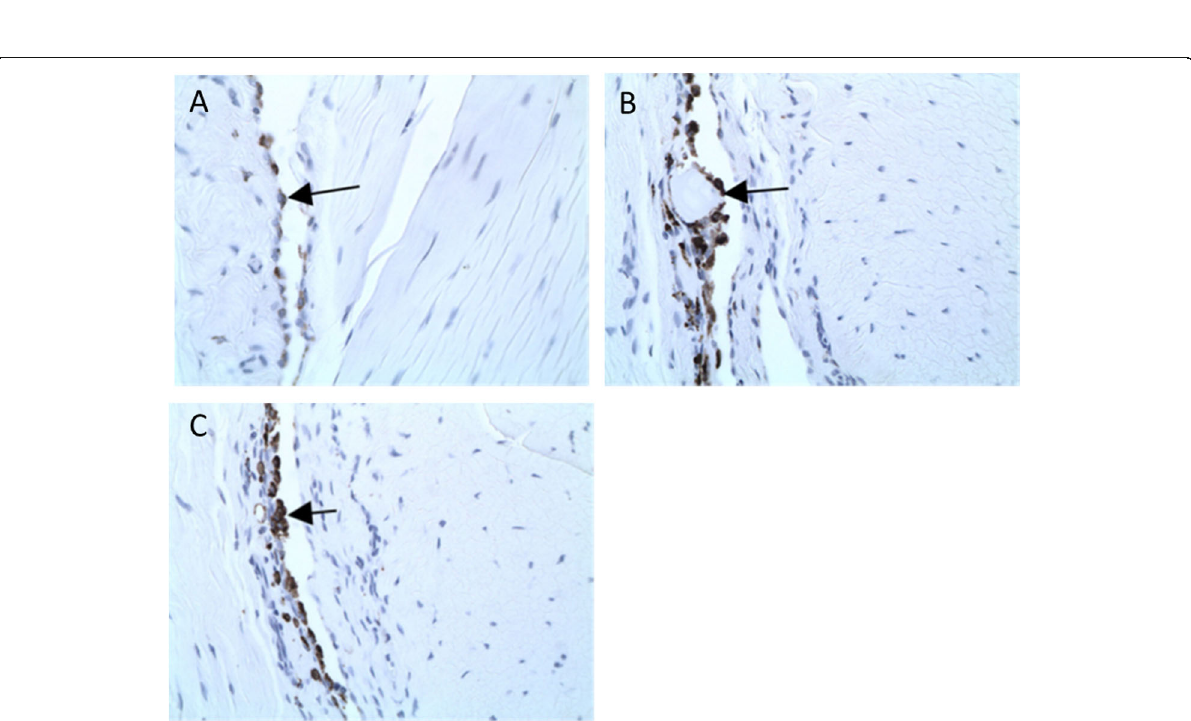
Fig. 4 ED-1 staining on the lateral tibial surface. a Uninjected left knee. Arrow identifies normal background level of ED-1-positive macrophages in synovium. b PBS injections at Days 7, 14, and 21 in the right knee. Arrow identifies ED-1-positive macrophages surrounding degenerating cartilage fragment in synovium. There is a mild increase over normal background levels, likely as a result of the disease process (rather than the treatments). c IA-BioHA injections (0.5 mg/rat) at Days 7, 14, and 21 in the right knee. Arrow identifies ED-1-positive macrophages in synovium. There is a mild increase over normal background levels, likely as a result of the disease process. Images were acquired at 400x